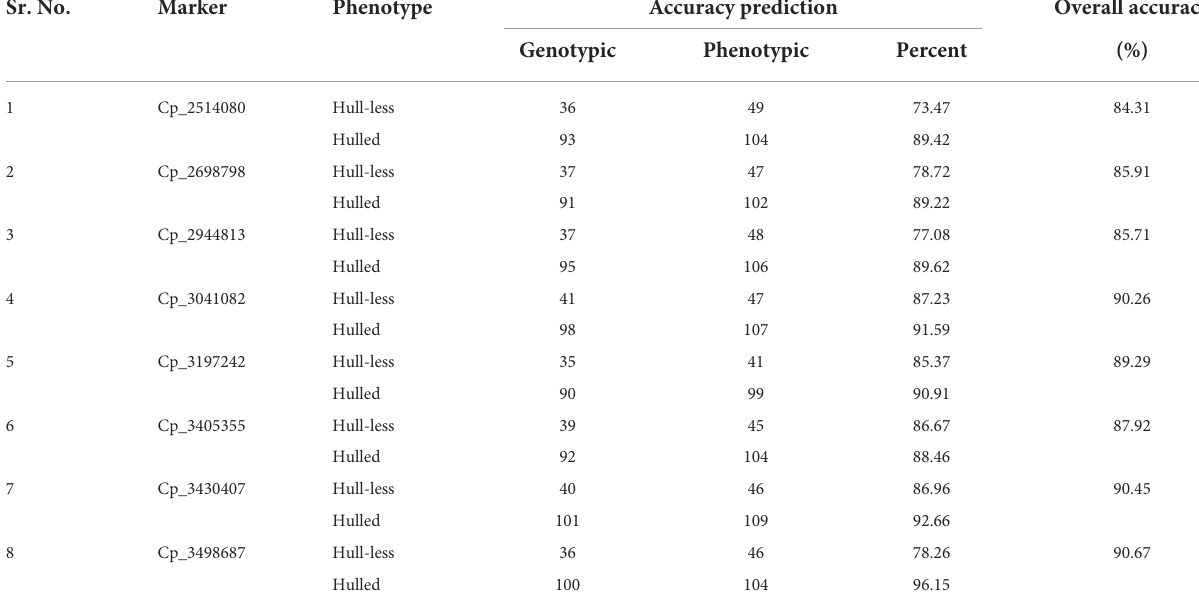
TABLE 2 Marker-phenotype association in amplified F 2 individuals of HP111 × HLP36 cross. Sr.